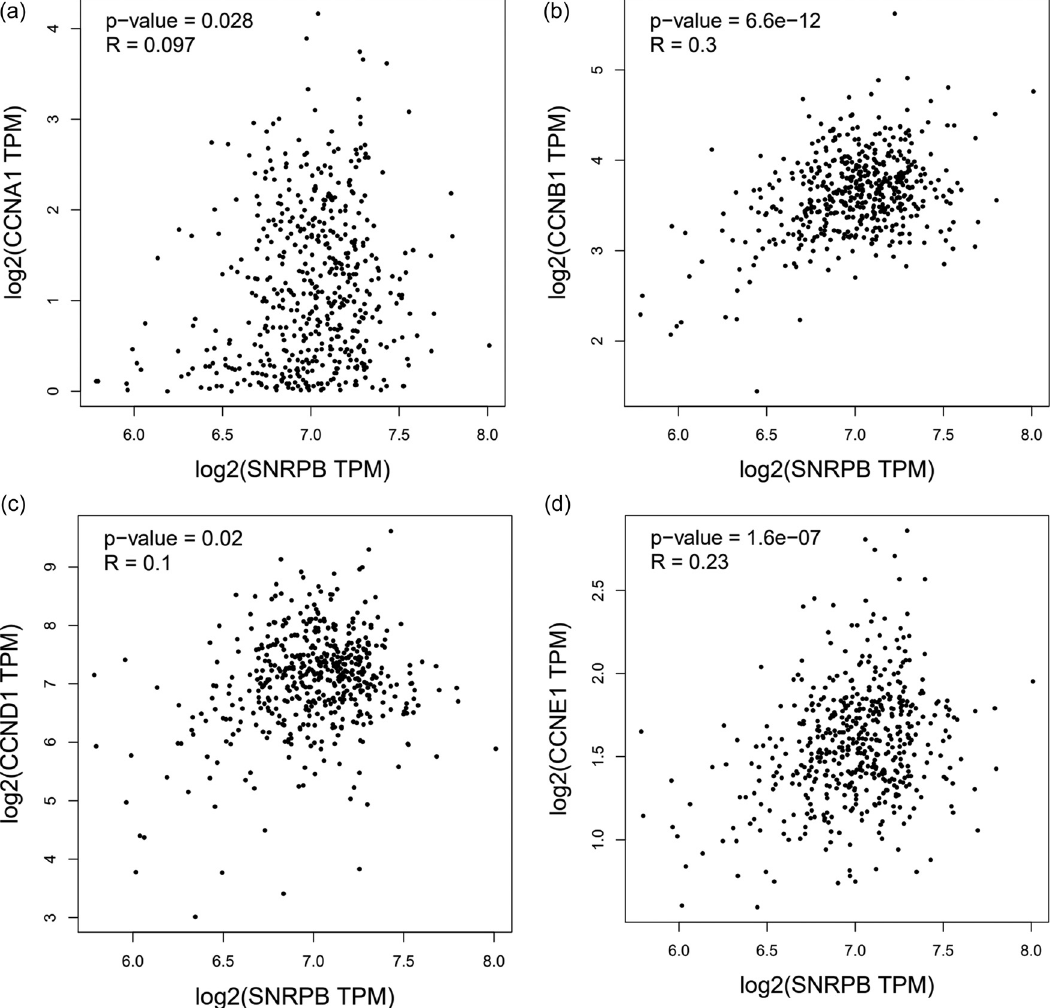
Figure 3: SNRPB expression is positively correlated with cell cycle - related gene expression: ( a – d ) expression correlation between SNRPB and cell cycle - associated genes in THCA tissues shown by GEPIA